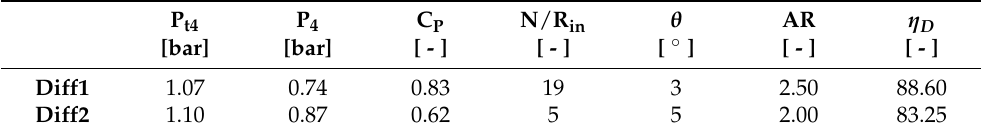
Table 5. Outlet diffuser preliminary design. Parameters according to Dixon